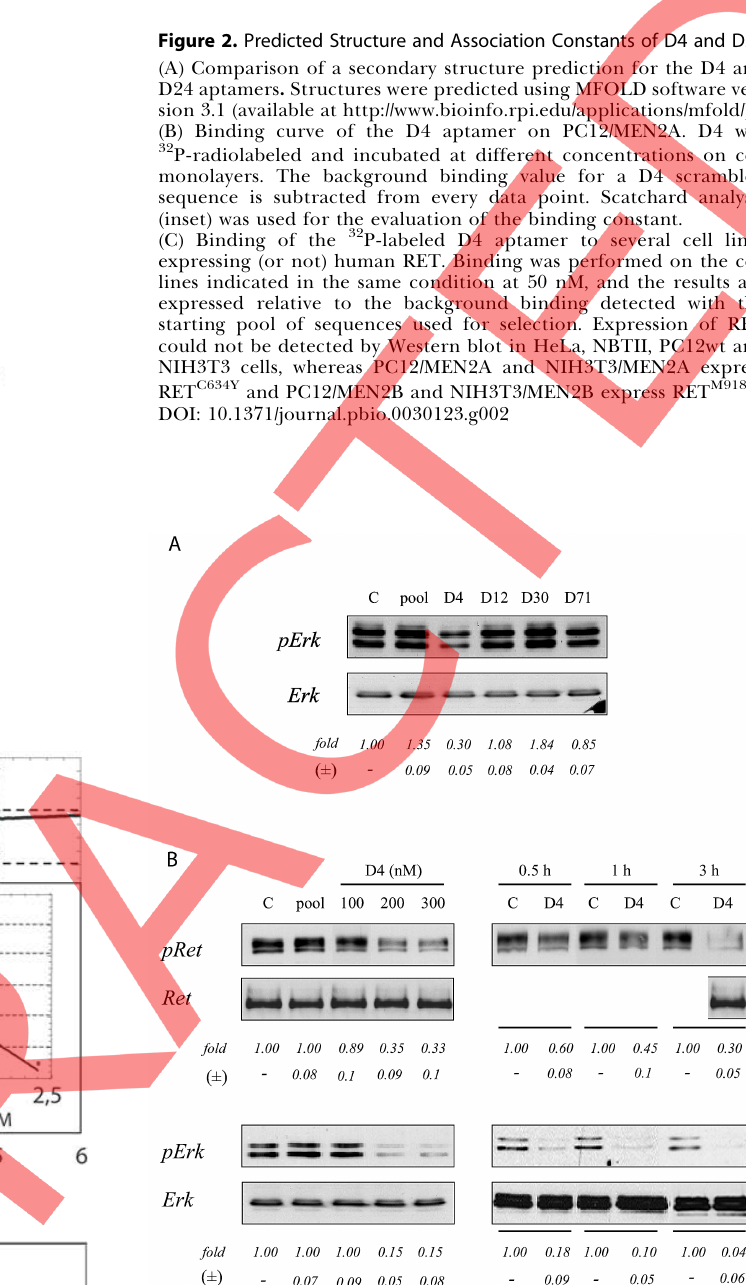
Figure 3. Effect of Selected Aptamers on RET C634Y Activity (A) PC12/MEN2A cells were either left untreated or treated for 16 h with 150 nM of the indicated RNA aptamer, or the starting RNA pool (pool). Cell lysates were immunoblotted with anti-(phospho)-ERK (pErk), then stripped and reprobed with anti-ERK (Erk) to confirm equal loading. Values below the blots indicate signal levels relative to untreated controls. (B) PC12 / MEN2A cells were treated for 1 h with increasing amounts of D4 (left blots) or with 200 nM D4 for the indicated incubation times (right blots). Cell lysates were immunoblotted with anti-(Tyr- phosphorylated)-RET (pRet) or anti-(phospho)-ERK (pErk) antibod- ies, as indicated. To confirm equal loading the filters were stripped and reprobed with anti-RET (Ret) or anti-ERK (Erk) antibodies, respectively. In (A) and (B), ‘‘ C ’’ indicates mock-treated cells. Quantitations were done on the sum of the two RET- or ERK- specific bands, and values are expressed relative to the control, arbitrarily set to 1. Standard deviations are indicated ( n = 4). DOI: 10.1371/journal.pbio.0030123.g003